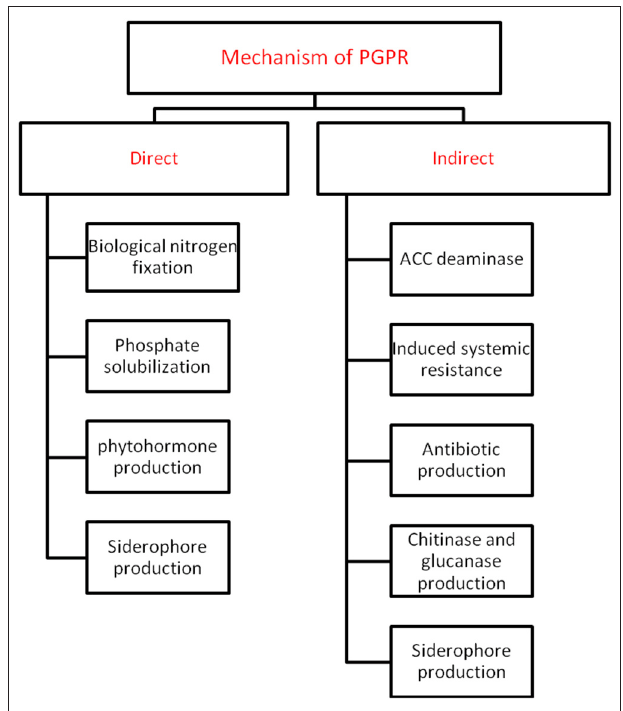
FIGURE 1 | An overview of different types of direct and indirect mechanisms adopted by PGPR against abiotic